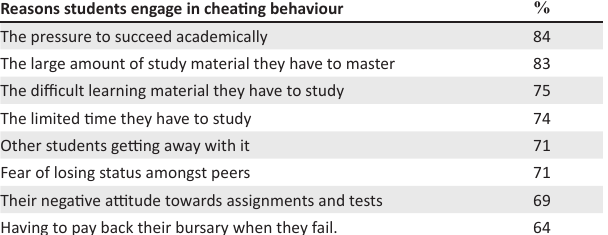
TABLE 3: Opinion of respondents regarding contextual influences on cheating